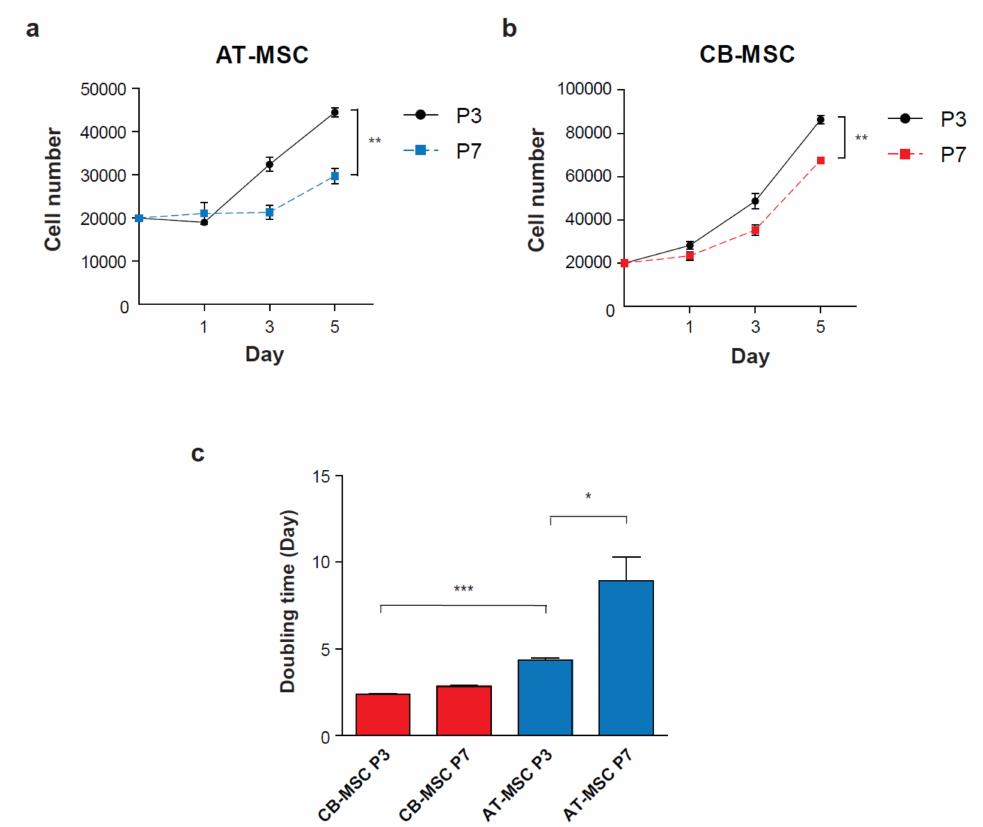
Figure 2. Ex vivo expansion of MSCs at di ff erent passage numbers. Cell proliferation assay was performed to determine the growth rate of early (Passage 3) and late passage (Passage 7) of ( a ) AT-MSC and ( b ) CB-MSC. Cells were counted on day 1, 3 and 5 ( n = 3). ( c ) Doubling times of MSCs were